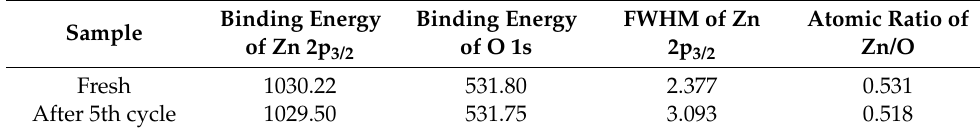
Table 5. The change of Zn to O ratio of fresh and used PCH15/HT